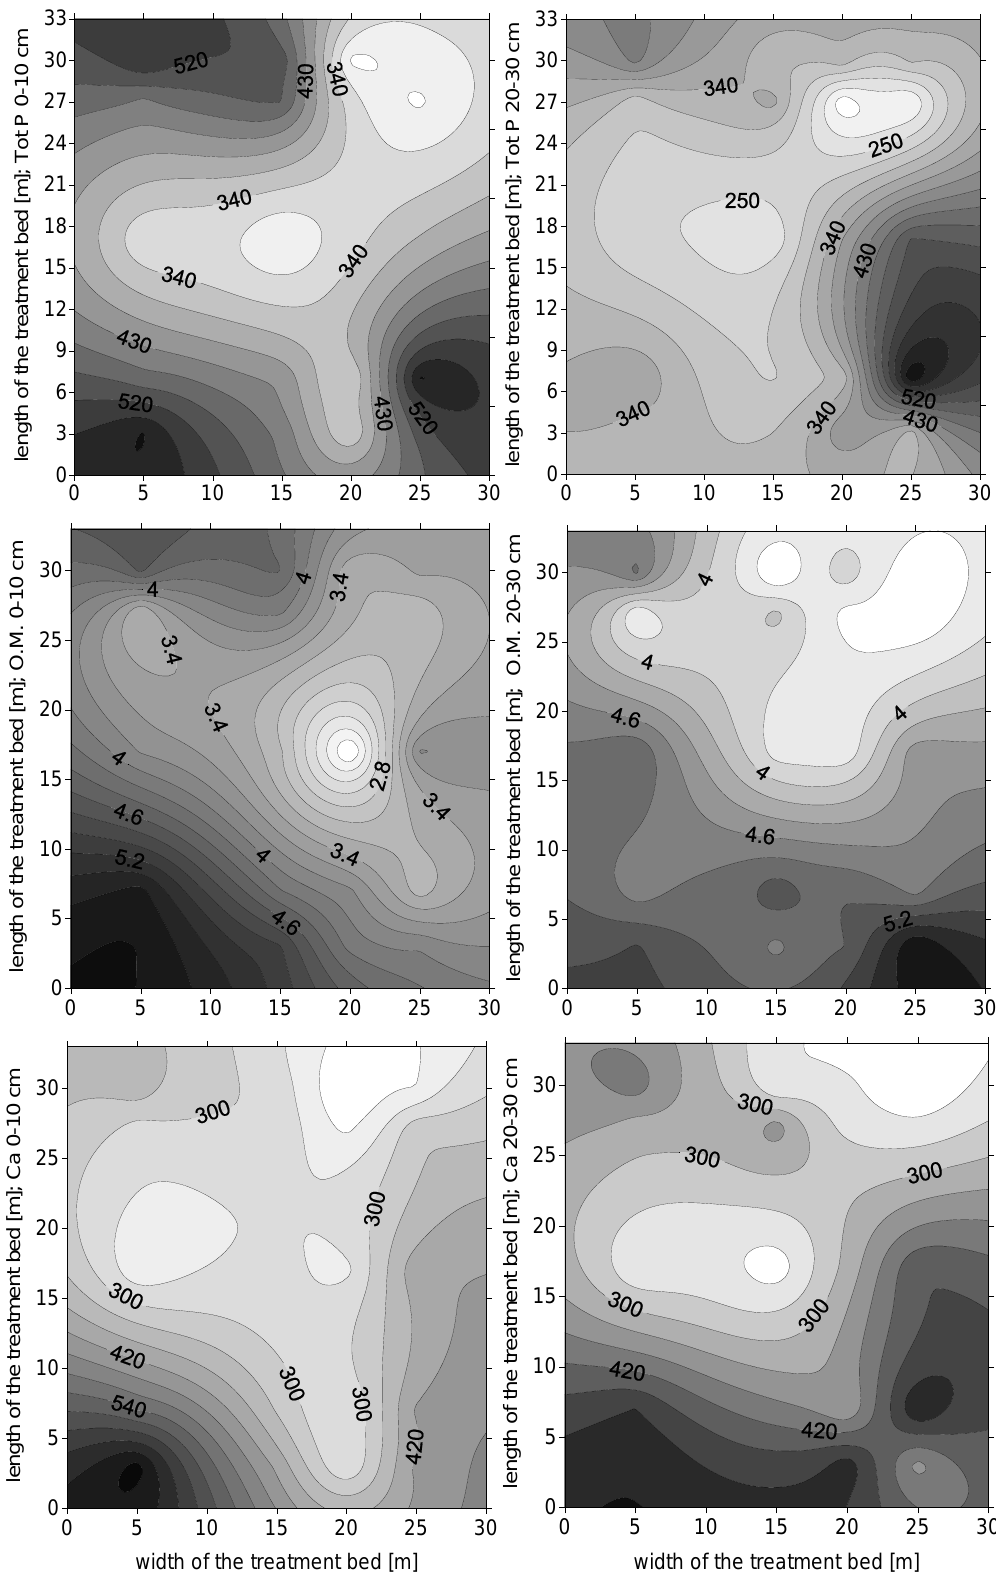
Figure 3. Horizontal distribution of P (mg kg –1 ) (top panels), organic matter (OM) (%) (middle panels) and Ca (mg kg –1 ) (bottom panels) in the upper layer (0–10 cm) (left) and lower layer (20–30 cm) (right) of the horizontal subsurface flow constructed